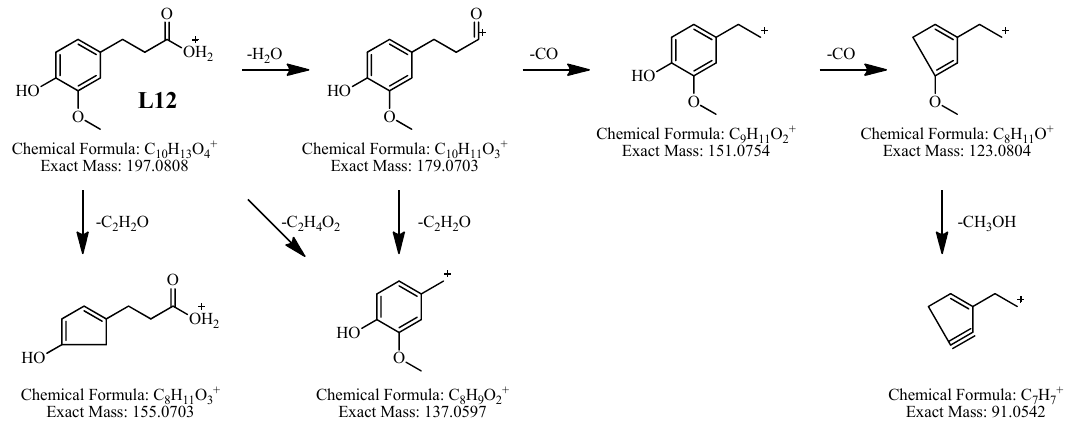
Figure 8. Proposed fragmentation pathways of hydroferulic acid ( L12 ) in positive ion